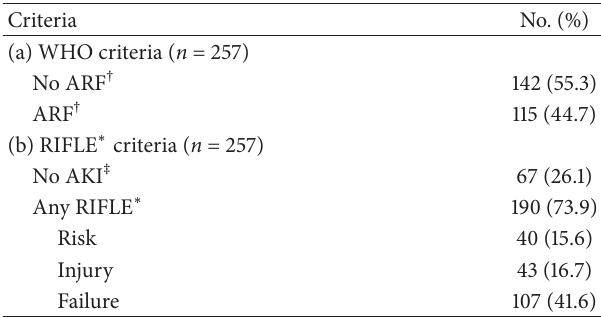
Table 1: Incidence of acute renal failure classified by the WHO 2006 and RIFLE ∗